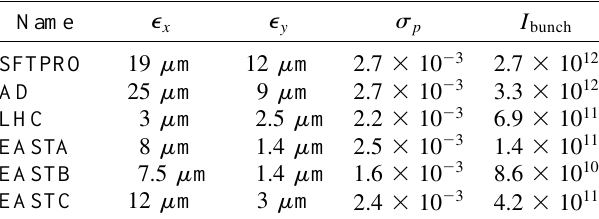
TABLE II. Parameters of beams used for comparative mea- surements. Emittances and momentum spread are 2 s values. Name